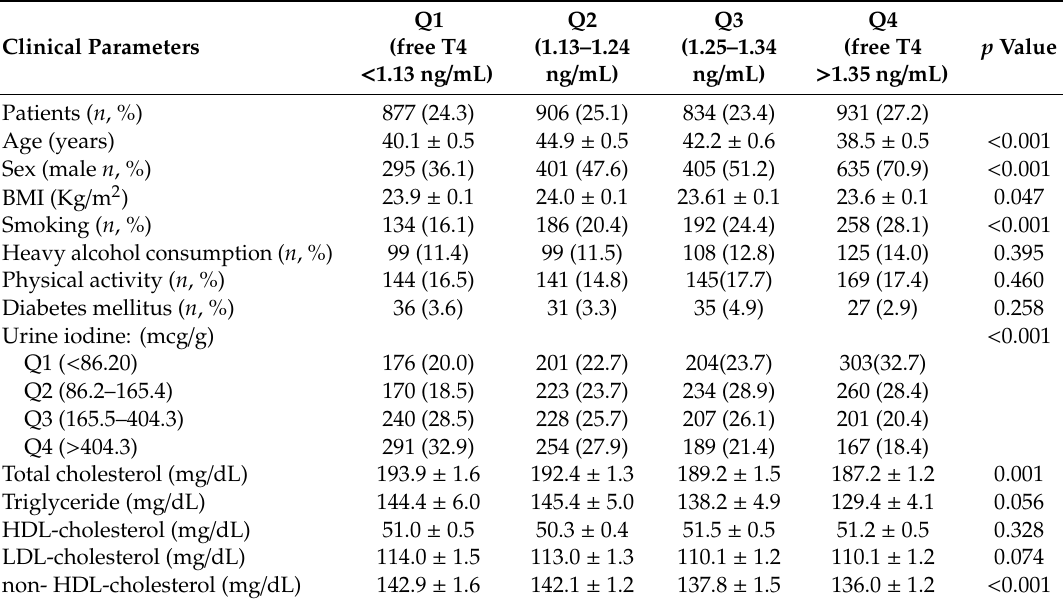
Table 1. Baseline characteristics of the patients based on free T4 levels.